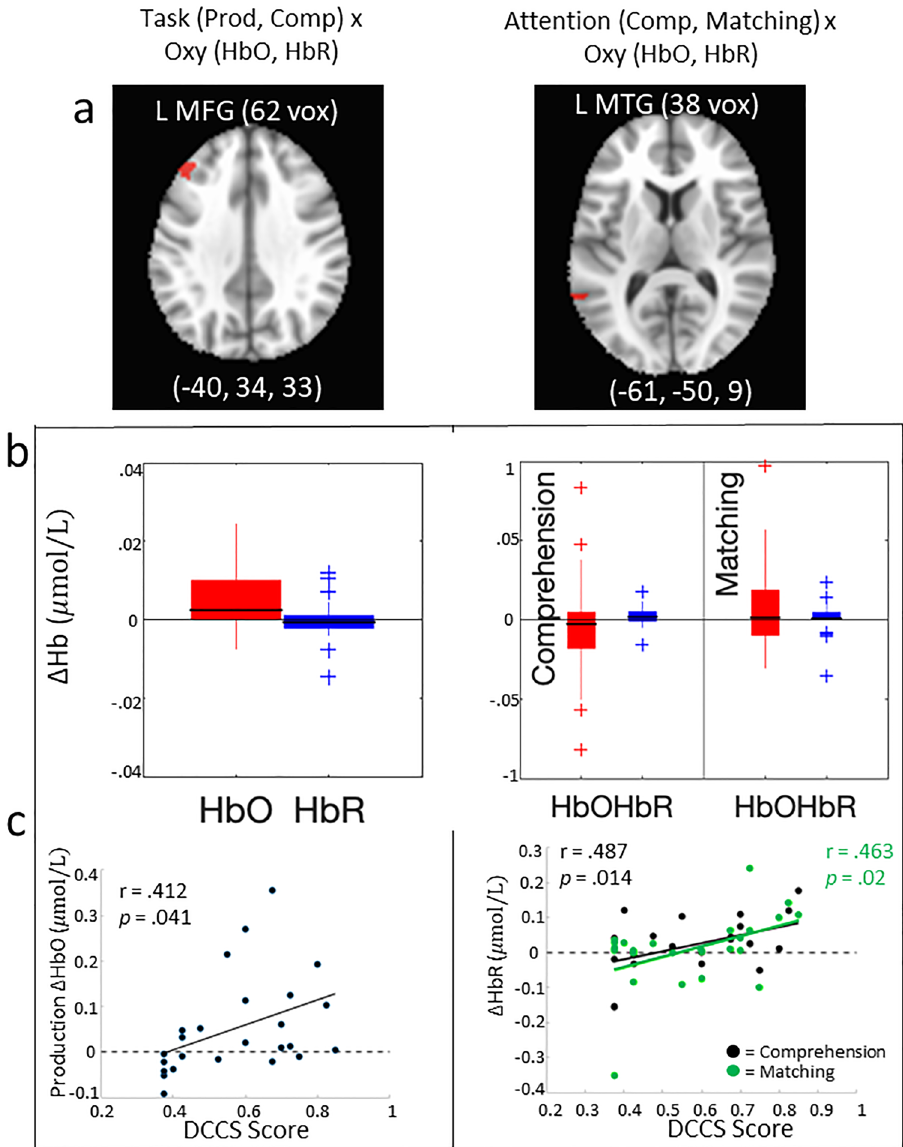
Figure 3. DCCS scores at 45 months were associated with DL activation at 33 months. ( a ) Location of clusters displaying activation in L MFG (middle frontal gyrus) and L MTG (middle temporal gyrus) ( b ) Boxplots of Hb values from clusters. Bars show the range from 25 to 75 percentiles of data. The median is marked by black line. Whiskers mark the range of data not considered outliers and outliers are indicated by + makers. ( c ) Hb concentration during the DL tasks at 33 months was associated with DCCS performance at 45 months